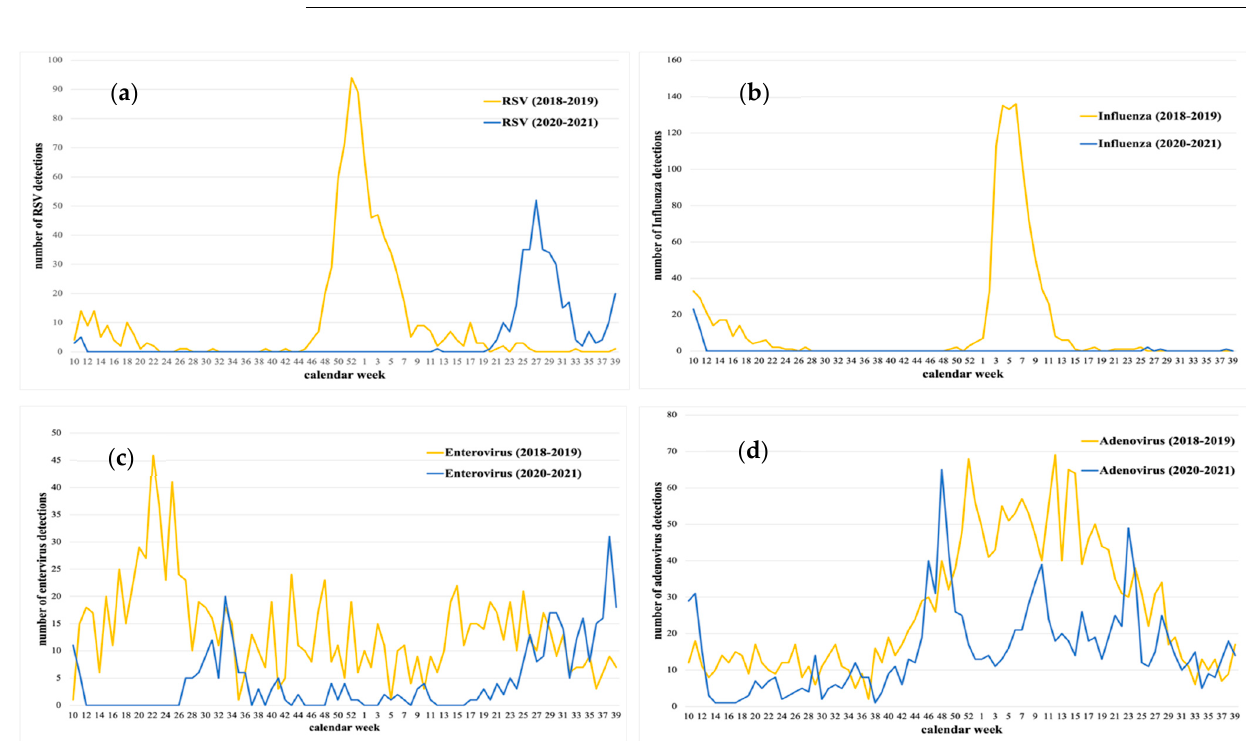
Figure 4. Detection comparison of weekly detection of ( a ) RSV, ( b ) influenza, ( c ) enterovirus, and ( d ) adenovirus between the periods 2018–2019 and